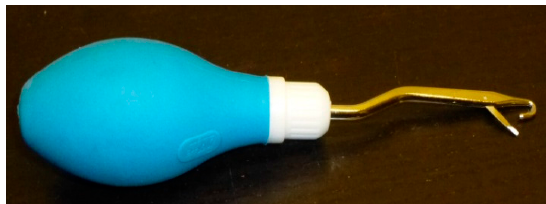
Figure A9. Garlic press.